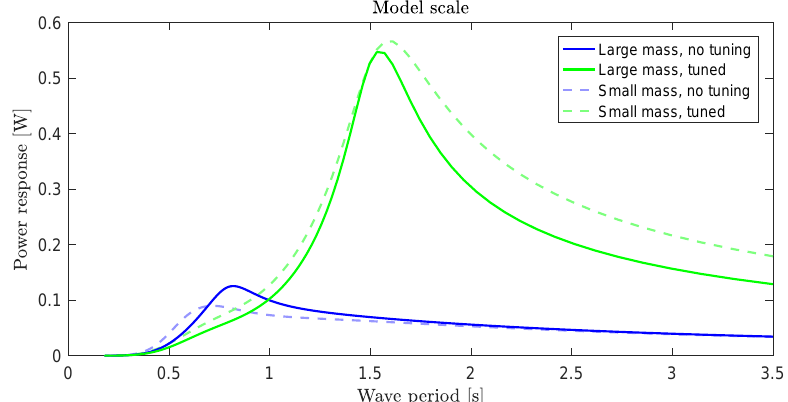
Figure 6. Power response for the system with original configuration (blue) and with stiffness tuned to give resonance at T 0 = 1.5s (green). The power response is drawn for a wave amplitude of 12.5 mm assuming no amplitude constraints. The mass alternatives small and large refer to Table